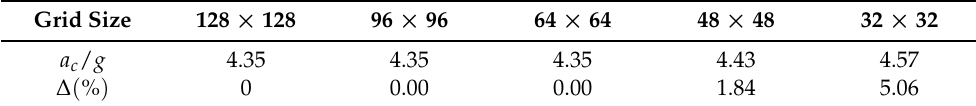
Table A2. Spacial grid size sensibility analysis of a c / g for EbFVM S in the linear regime. Grid Size